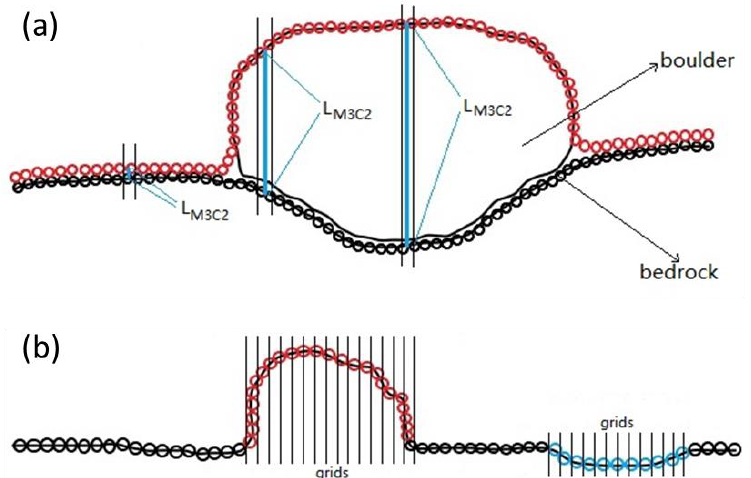
0.248 m, and 0.742 m, respectively, as obtained through accurate measurement with a tape measure. The volume of each box group is expressed as: